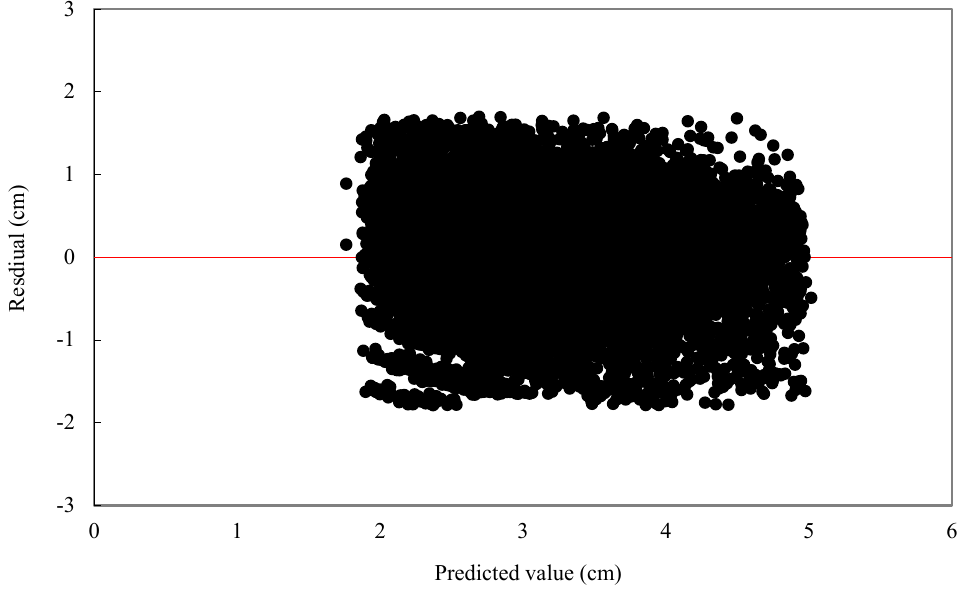
Figure 5. Weighted residuals and predicted values of simultaneous equations for SUR.